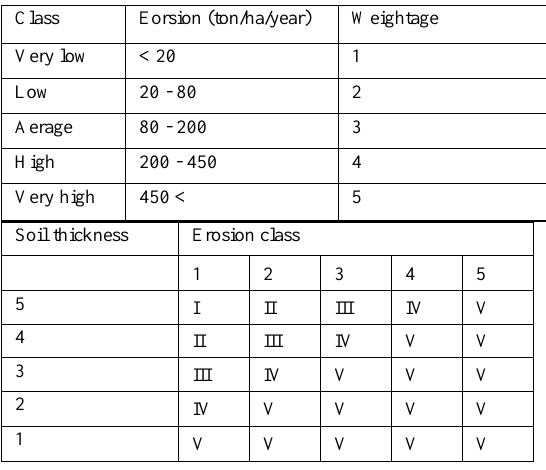
TABLE 7. Classification of erosion parameter.